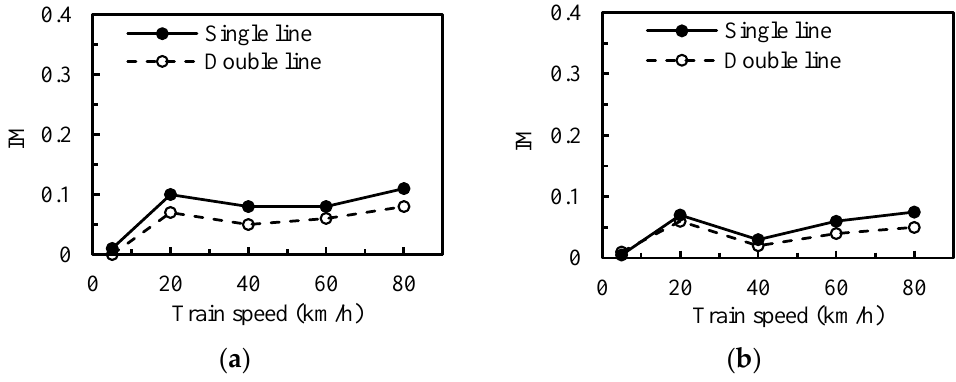
Figure 10. Impact factors calculated from deflections: ( a ) Section A-A; ( b ) Section C-C.